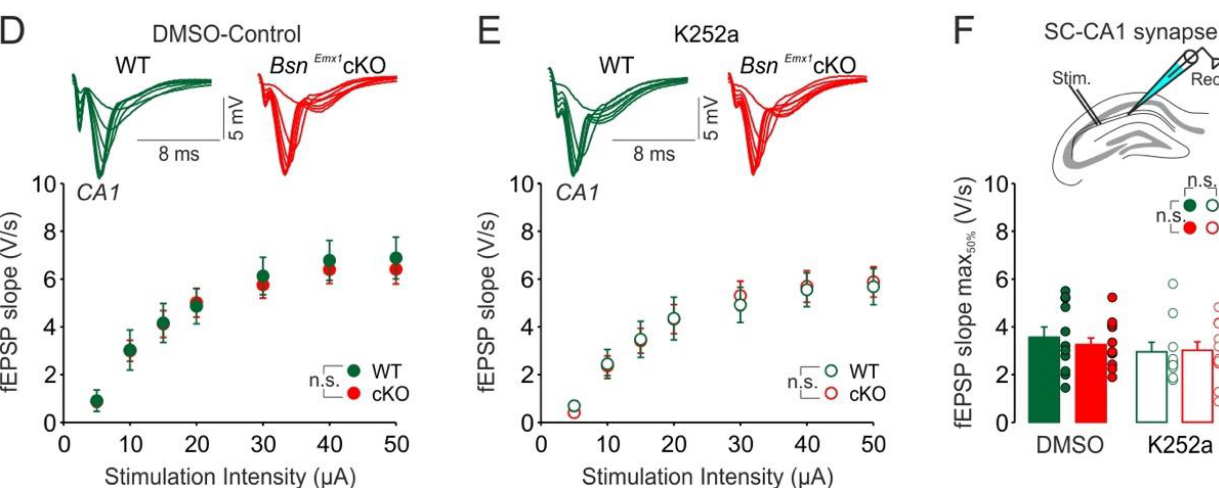
Figure 4. Hippocampal synaptic excitability in the Bsn Emx1 cKO mice is not altered during adolescence (~4–5 weeks-old). Input-Output (I-O) curves showing ( A ) no significant alterations in the fEPSP responses at the MPP-DG synapse of Bsn Emx1 cKO mice under control conditions and ( B ) under the blockade of TrkB receptors by K252a (200 nM). ( C ) Two-way ANOVA comparison of fEPSP slopes corresponding to 50% of maximum response revealed no genotype and no K252a treatment effect at the MPP-DG synapse. The positioning of the recording (Rec.) and stimulation (Stim.) electrodes for the MPP-DG synapse is depicted above the summary graph. I-O curves showing ( D ) no alterations in the fEPSP responses at the SC-CA1 synapse of Bsn Emx1 cKO mice under control conditions and ( E ) after k252a. ( F ) Comparison of fEPSP slopes corresponding to 50% of maximum response shows no genotype and no treatment effect at the SC-CA1 synapse. The positioning of the recording (Rec.) and stimulation (Stim.) electrodes for the SC-CA1 synapse is depicted above the summary graph. Merged traces to increasing stimulation strengths (5–50 µ A) for each condition are depicted above the I-O curves (WT: Green; Bsn Emx1 cKO: Red). slices were pre-treated (2 h) either with vehicle DMSO (DG-WT: N = 5 mice, n = 11 slices; DG- Bsn Emx1 cKO: N = 5 mice, n = 11 slices; CA1-WT: N = 5 mice, n = 11 slices; CA1- Bsn Emx1 cKO: N = 5 mice, n = 12 slices) or K252a (DG-WT: N = 5 mice, n = 12 slices; DG- Bsn Emx1 cKO: N = 5 mice, n = 11 slices; CA1-WT: N = 5 mice, n = 10 slices; CA1- Bsn Emx1 cKO: N = 5 mice, n = 12 slices). n.s. indicates not significant. Two-way repeated ANOVA followed by posthoc comparison using Fisher LSD Method was performed for ( A , B , D , E ). Two-way ANOVA followed by posthoc comparison